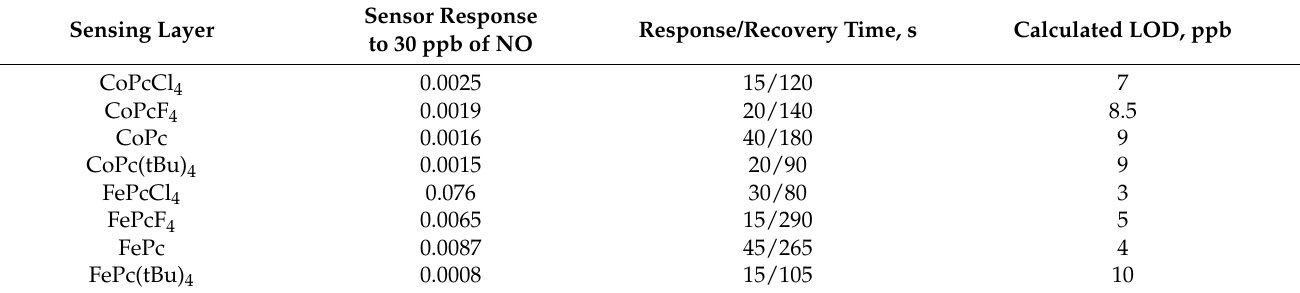
Table 2. Sensor characteristics of MPcR 4 (M = Co, Fe; R = H, F, Cl, tBu) films to 30 ppb of NO.